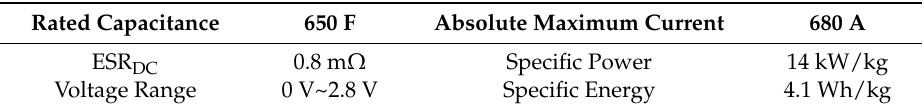
Table 2. UC Parameters.